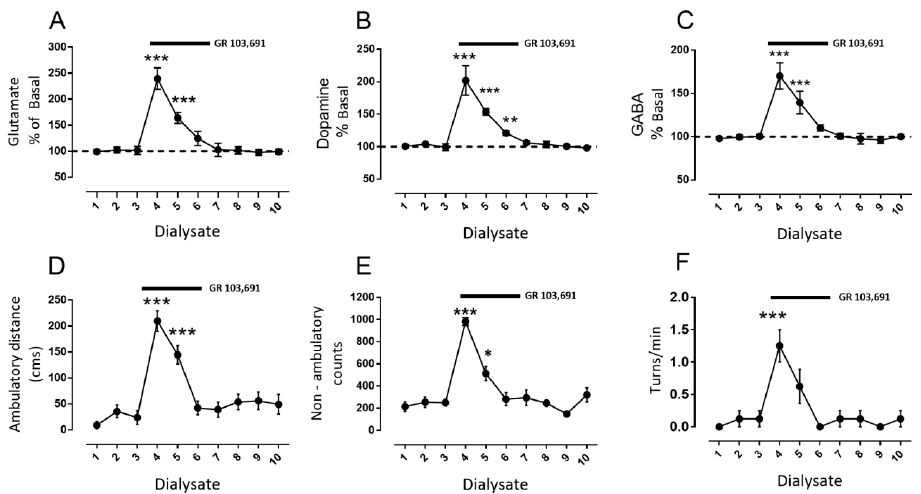
Figure 1. Localization of the tip of the microdialysis cannula within substantia nigra pars reticulata (SNr) of the experiments of this project. At the upper left is shown a microphotograph of a sagittal slice of the brain of a rat, showing the trajectory of guide cannula and the tip of the dialysis cannula within the SNr. Images like this were obtained and compared with schematic diagrams from the Atlas of Paxinos and Watson [38], the location of the tip of the cannula in the di ff erent experiments of this project is indicated with the number of the corresponding figure.